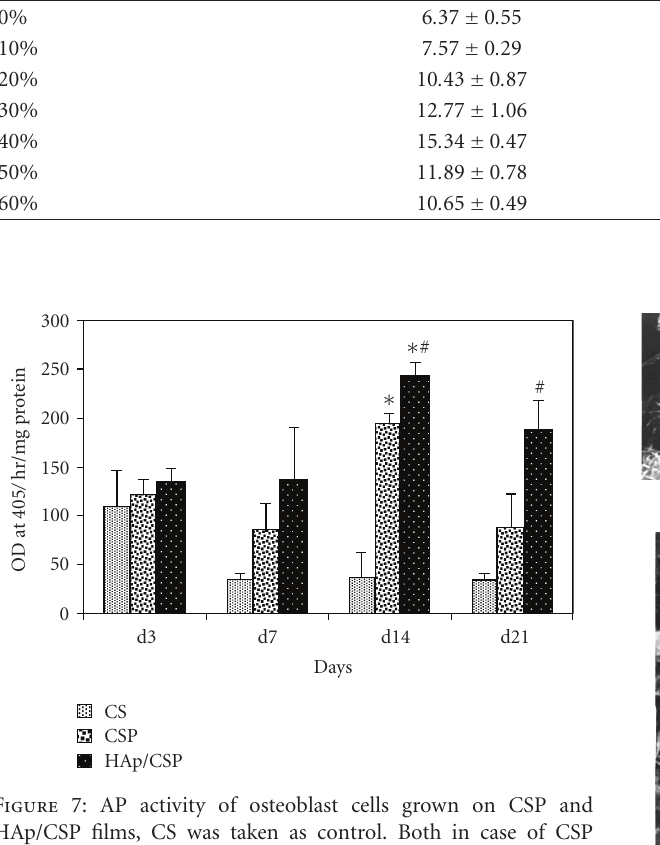
Table 2: Mechanical properties of HAp/CSP nanocomposite samples. Number after ± sign corresponds to the standard deviation. n-HAp particles loaded (w/w)